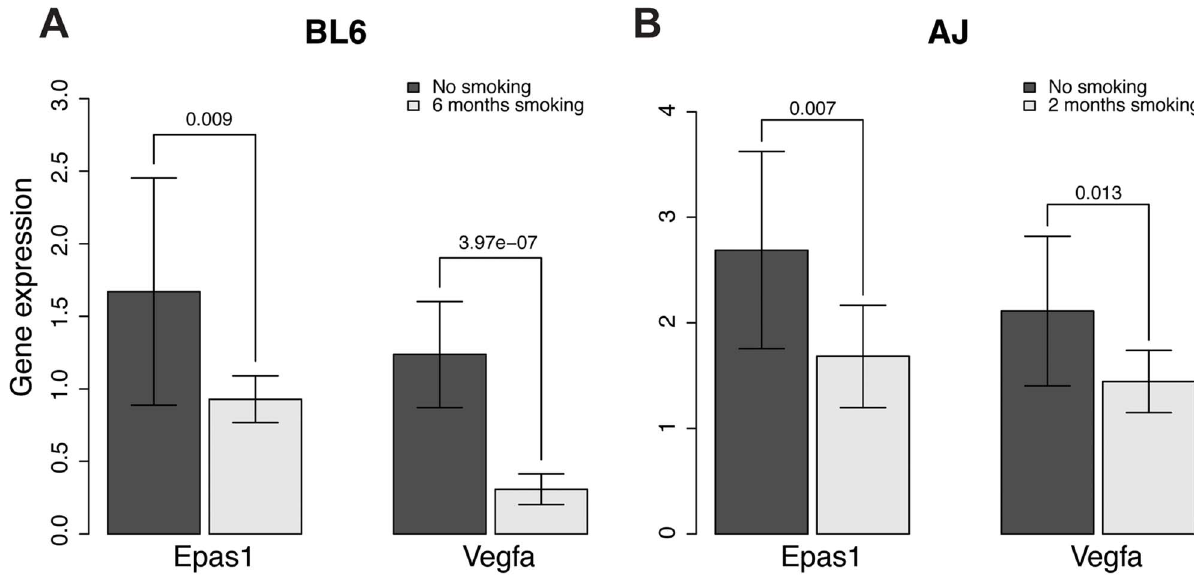
Fig. 5. Gene expression levels of Epas1 and Vegfa were lower in chronic smoking mice than non-smoking age-matched mice at the time when COPD develops in different mouse models. A ) Gene expression levels of Epas1 and Vegfa in C57BL/6J mice that develop COPD after 6 months chronic exposure to cigarette smoke. B ) Gene expression levels of Epas1 and Vegfa in A/J mice that develop COPD after 2 months chronic exposure to cigarette smoke. The t-test was used to compare Epas1 or Vegfa expression levels in mice with or without chronic smoke exposure.